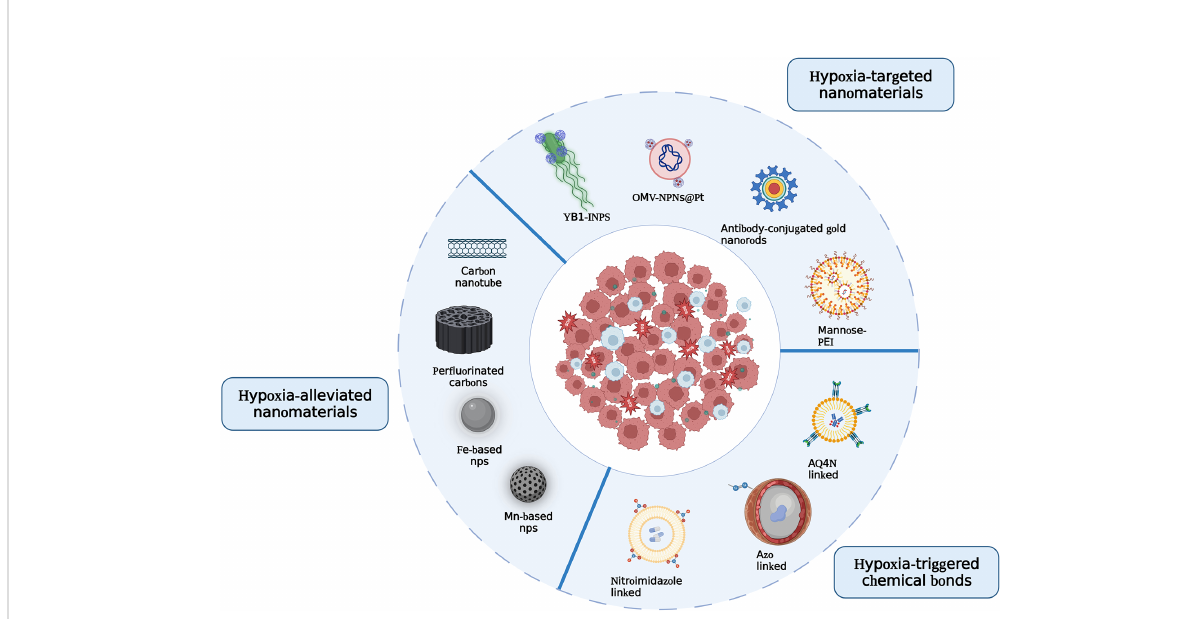
FIGURE 4 Illustration of the principles to design hypoxia-responsive